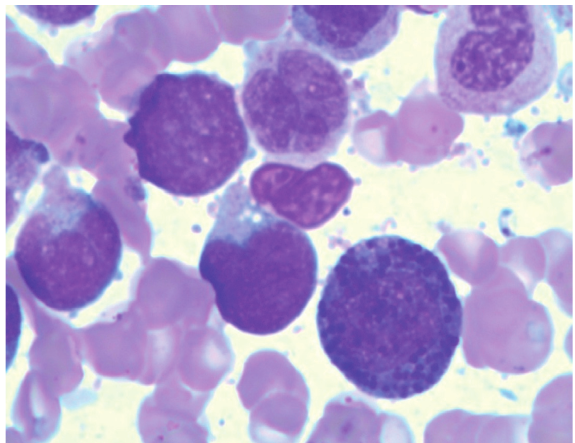
Figure 1: Bone marrow morphology: increased blasts, promonocytes, and atypical eosinophils with large basophilic granules.